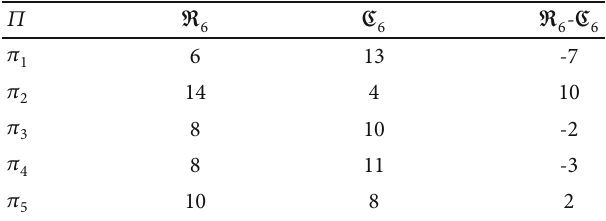
Table 19: The third negative pole score table.